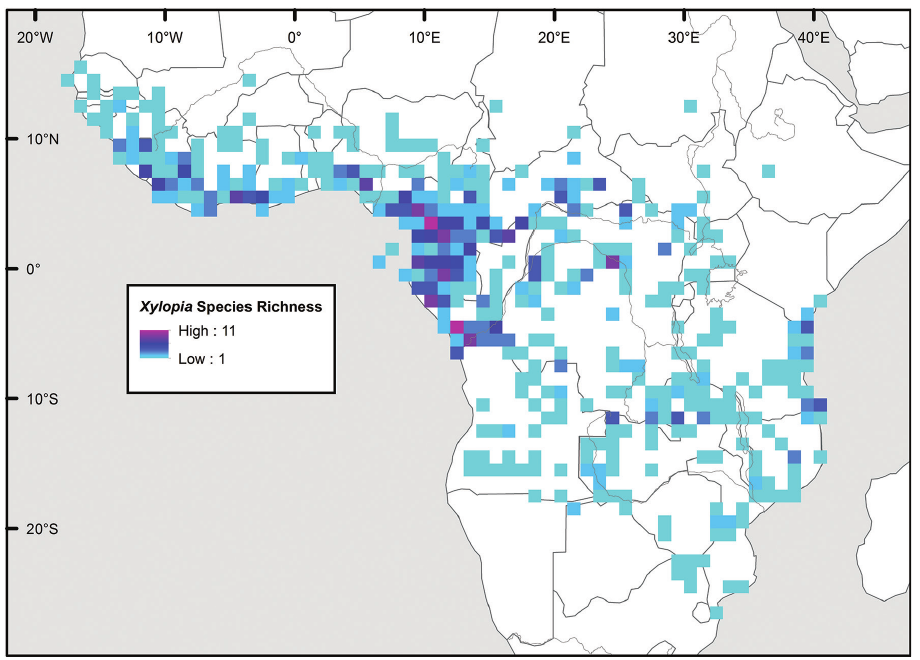
Figure 5. Xylopia species richness in Africa, plotted by 1° × 1° Lat × Long grid cell. Bolder lines represent country borders, fainter lines lakes and major